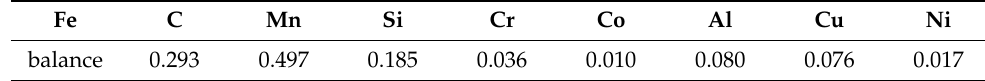
Figure 2. Ferrite matrix of the flange, 3% Nital. Table 1. Chemical composition of the flange steel matrix in